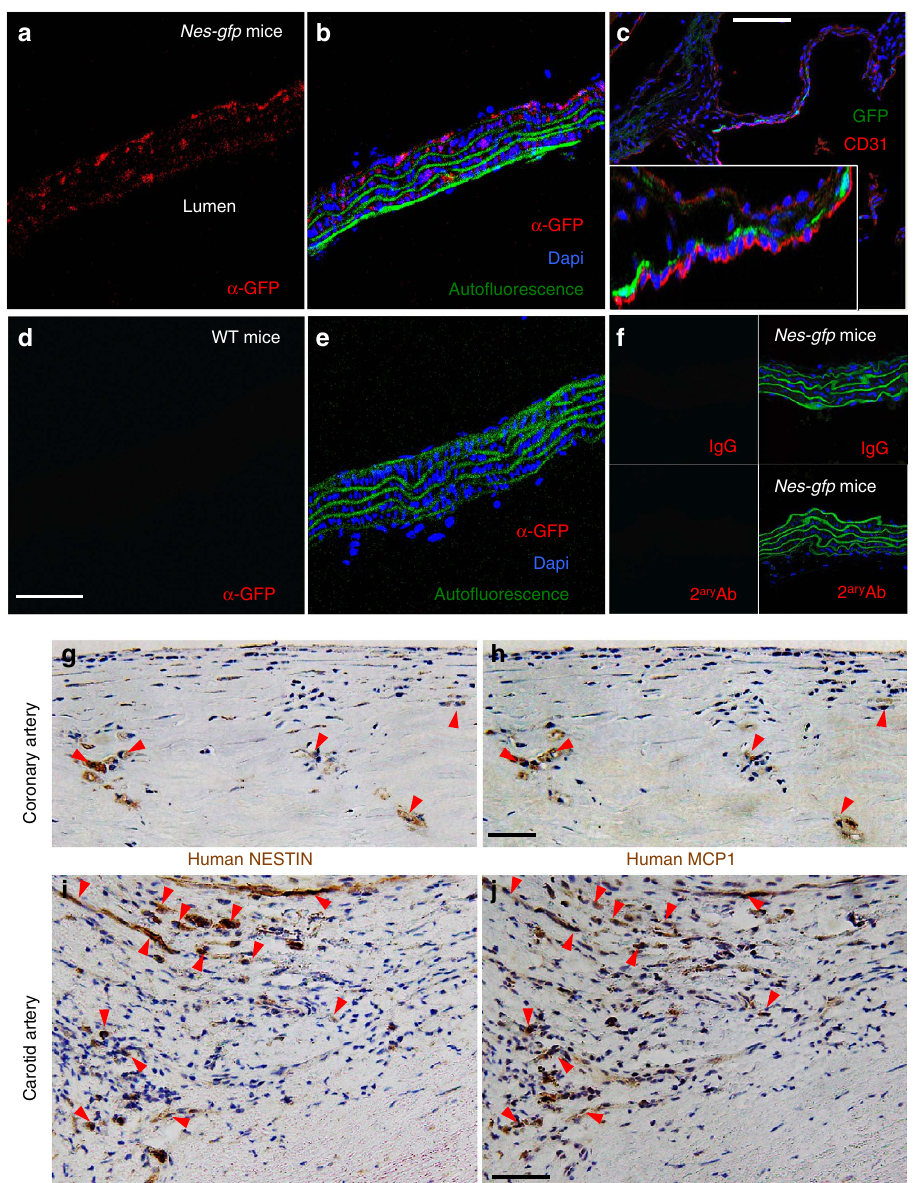
Figure 4 | Nestin þ cells in the aortic adventitia and media express Mcp1 in mice and humans. Immunofluorescence of sections from ( a , b , f ) thoracic aorta and ( c ) aortic valves from Nes-Gfp mice using antibodies against ( a , b ) GFP and ( c ) CD31 (red). Note that nestin þ cells are mainly distributed in the adventitia ( b ) or in close proximity of valve endothelial cells ( c ). Inset, high magnification of the aortic leaflets. ( d , e ) Immunofluorescence of representative control section from WT thoracic aorta using antibodies against GFP (red). The absence of red signal demonstrates the specificity of the staining. ( b , e ) The autofluorescence of the smooth muscle layer is shown in green. ( f ) Negative control immunofluorescence on Nes-gfp aorta using control IgG (top panels) and/or secondary antibodies (bottom panels). ( b , c , e , f ) Nuclei were counterstained with DAPI (blue). ( g – j ) Immunofluorescence of ( g – i ) NESTIN and ( h – j ) MCP1 in consecutive cross sections from human ( g , h ) coronary and ( i , j ) carotid artery samples. Red arrowheads depict cells that express both proteins in consecutive sections. ( a , b , d – f,g – j ) Scale bars, 50 m m, ( c ) 100 m